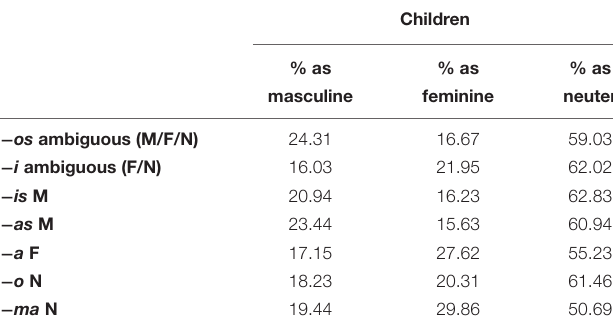
TABLE 9 | Distribution of responses for novel nouns by the younger group (children).